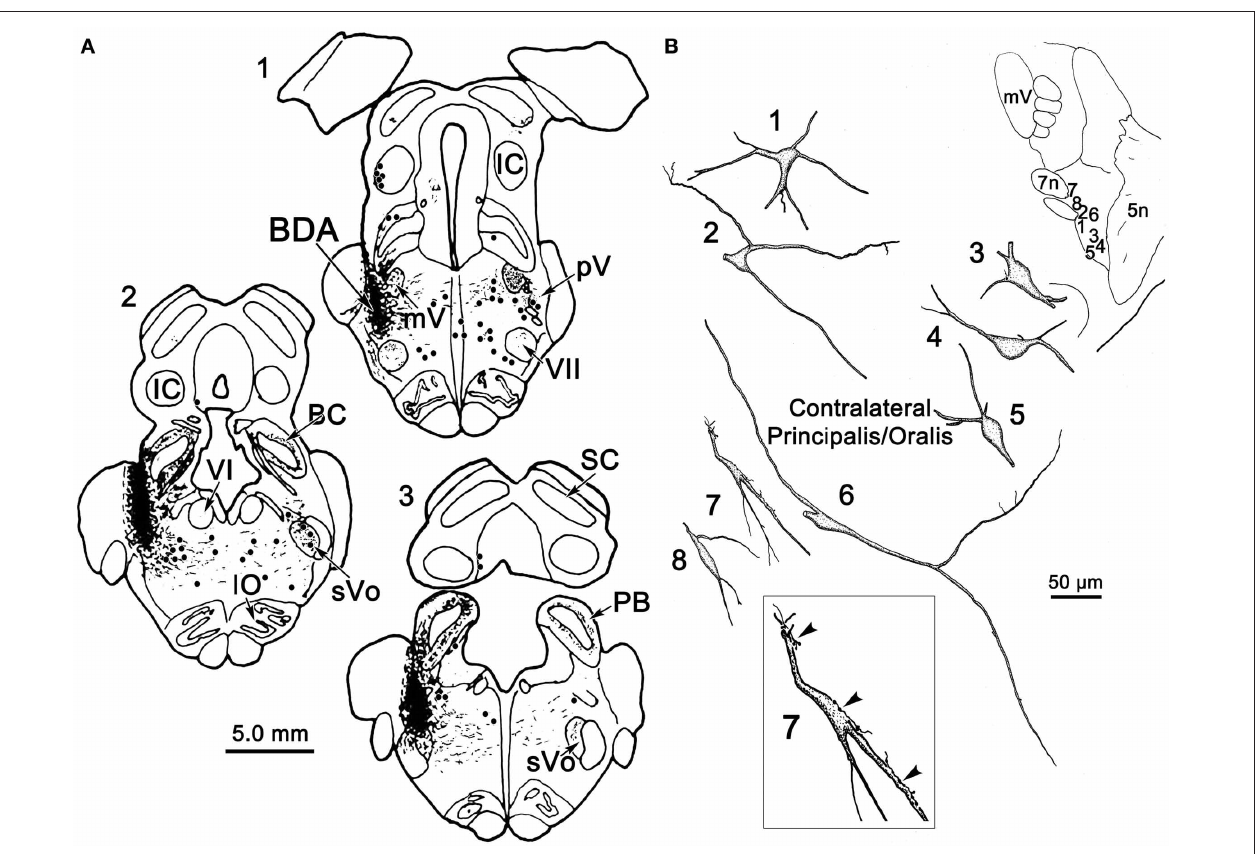
FIGURE 2 | (A) Showsa BDA injection into the left pV and sVo, with retrogradelylabeledcells (dots),axons(lines), and terminals(stipple) indicated. (B) Themorphologyof retrogradelylabeled cells and axonsfoundin the